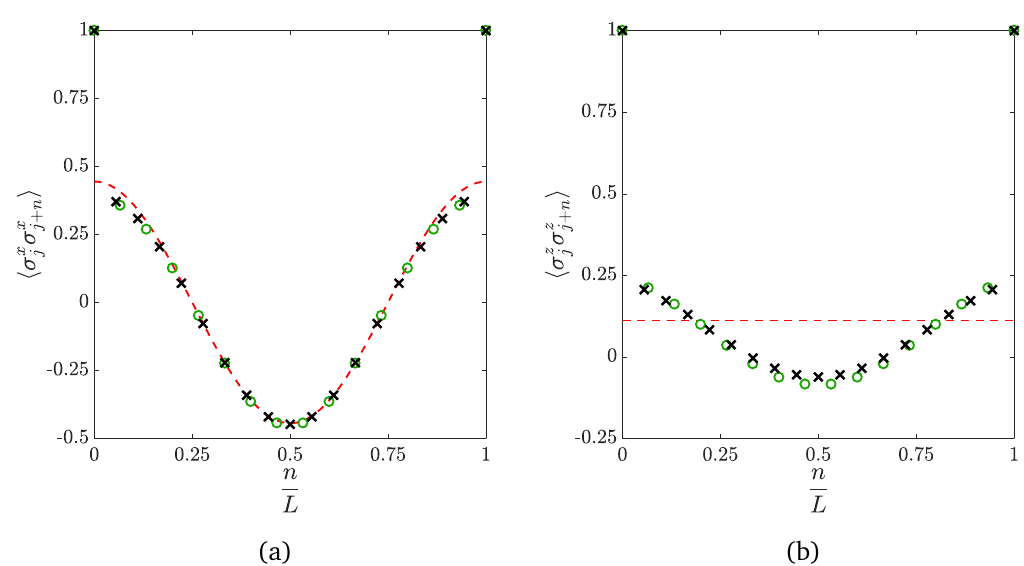
Figure 11: (a) Quantum correlation functions 〈 ˆ σ x L = 15 and black crosses for L = 18) versus averaged classical correlation functions (red dashed line), with anisotropy δ = 1 and classical period (cid:96) = 1. (b) The same comparison for longitudinal correlators 〈 ˆ σ z